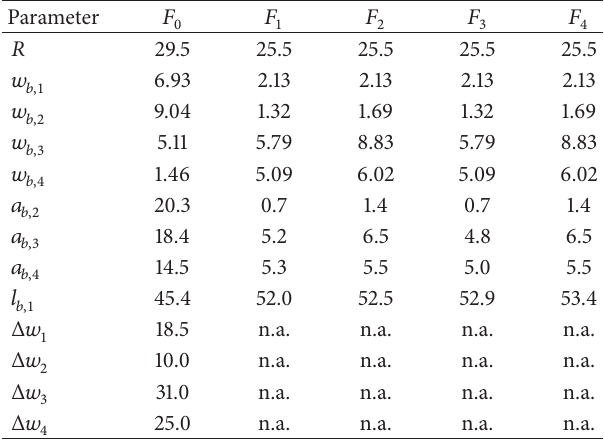
Table 3: Design parameters (measurement unit is